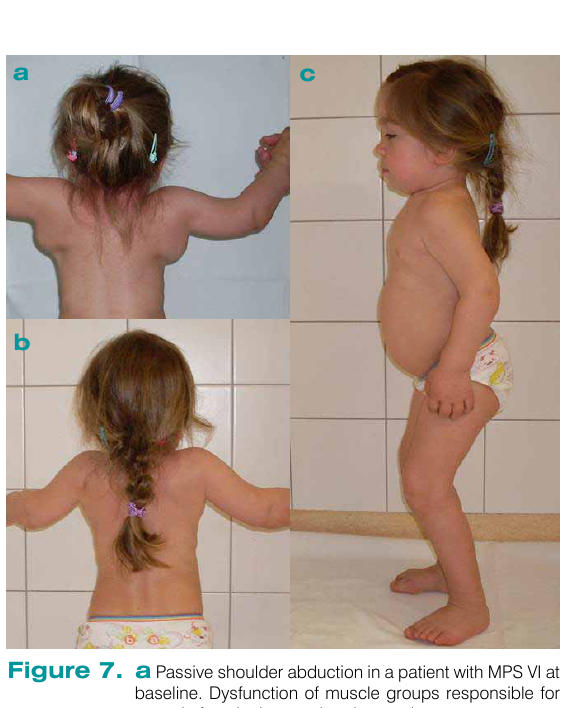
Figure 7. a Passive shoulder abduction in a patient with MPS VI at baseline. Dysfunction of muscle groups responsible for scapula functioning can be observed.